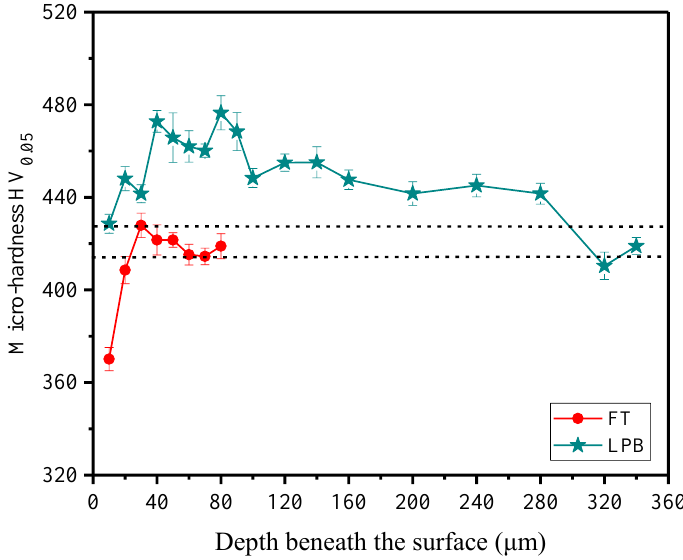
Figure 10. Micro-hardness distribution in depth beneath the surface.